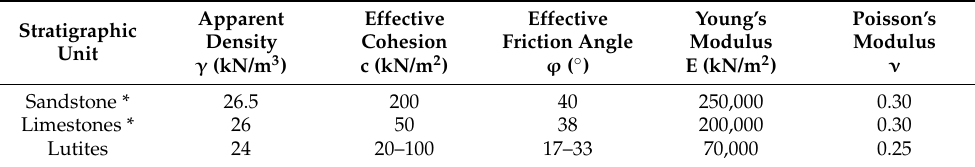
Table 2. Geomechanical parameters of the different